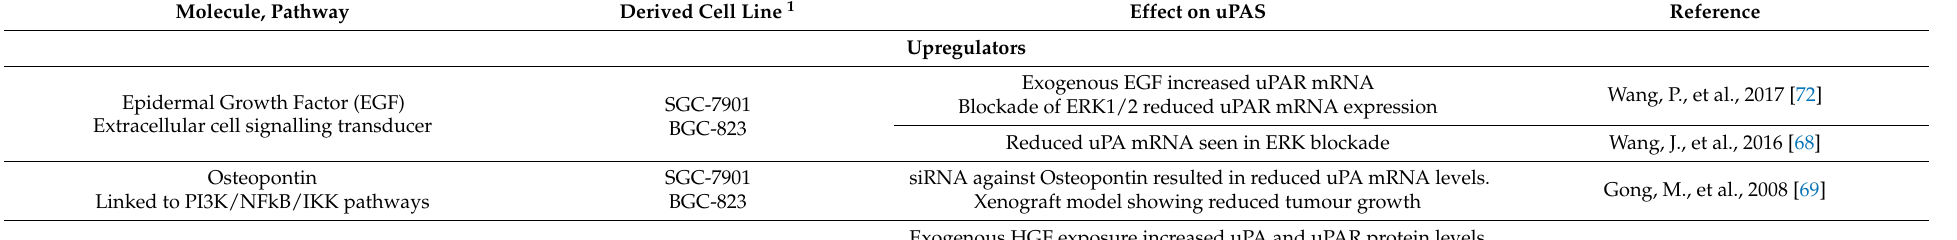
Table 1. Molecules and pathways linked to regulation of the urokinase plasminogen activation system (uPAS) in gastroesophageal adenocarcinoma cell